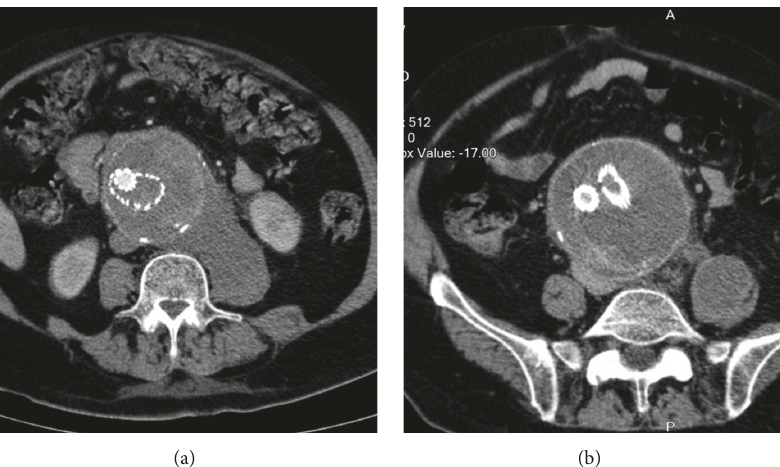
Figure 1: (a) Urgent CT reveals rupture of the aneurysm sac (a) in the arterial phase and (b) in the delayed phase without obvious endoleak.